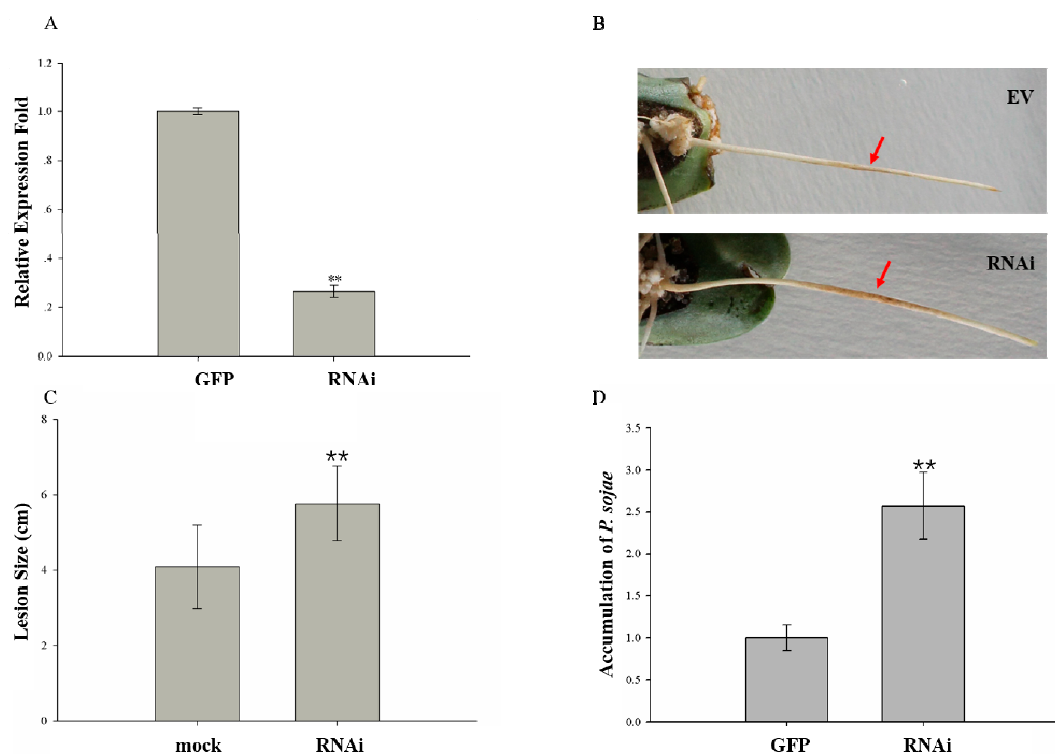
Figure 7. Silencing GmMED16-1 makes the soybean hairy roots susceptible to P. sojae .( A ) Expression pattern of GmMED16-1 in the mock and RNAi hairy roots; ( B ) Phenotype of the mock and RNAi hairy roots inoculated by mycelial pellets of P. sojae , the red arrow indicates the water-soked lesions after P. sojae inoculation of the transgenic hairy roots. EV represents the mock control and RNAi represents the gene silencing ones. ( C ) Lesion size of the mock and RNAi hairy roots inoculated by mycelial pellets of P. sojae ; ( D ) The biomass accumulation of P. sojae zoospores in the mock and RNAi hairy roots treated by the zoospores was quantified by qRT-PCR. GmCons4 was used as the reference gene. The error bars indicate the standard deviation from three replicates. ** indicate significant difference from control at p < 0.01, respectively.